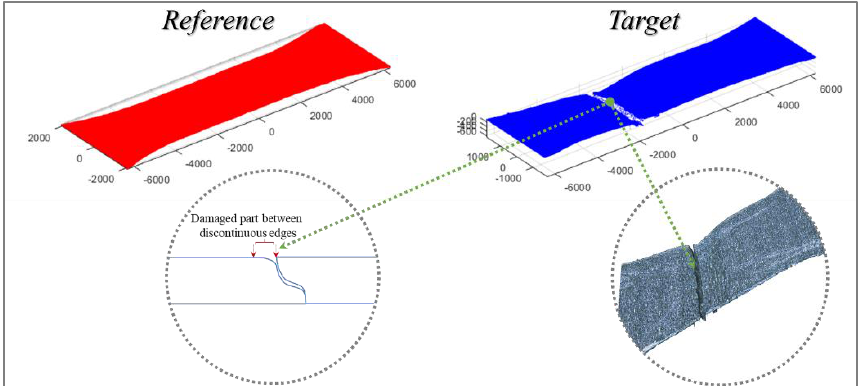
Figure 2. Topography data of the reference and the target conditions with illustration of the buckled part on the left side of the break zone.